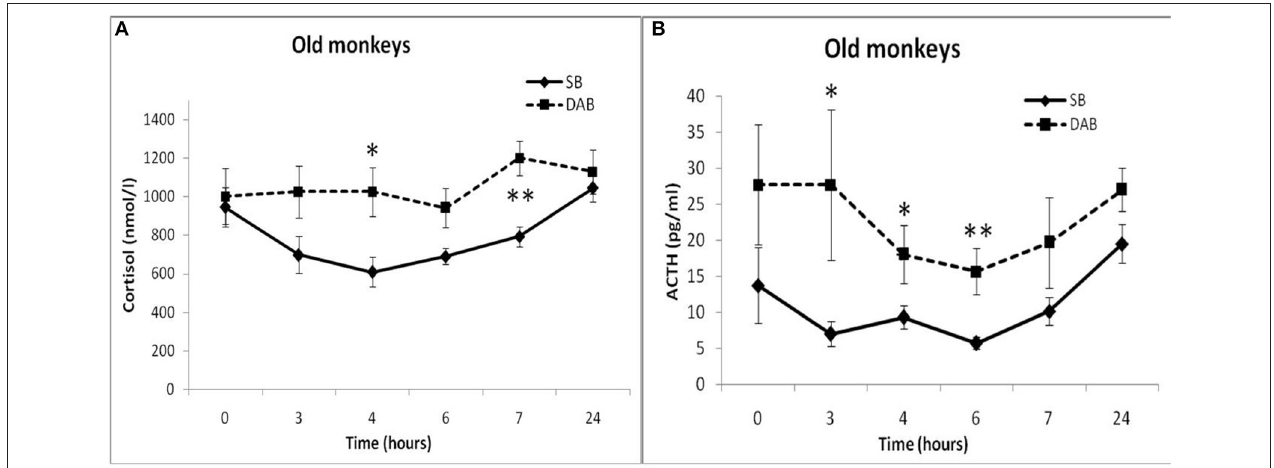
FIGURE 6 | Dynamics of CORT and ACTH concentrations in peripheral blood plasma of old female rhesus monkeys with SB (A) and DAB in response to administration of placebo (mean ± S.E.M). * p < 0.05; ** p < 0.01 vs. relative values in old animals with SB. (B) : 3h ( F = 9.112; df = 1;10; p = 0.035); 4h ( F = 13.339; df = 1;10; p = 0.016); 6h ( F = 35.264; df = 1;10; p = 0.002).